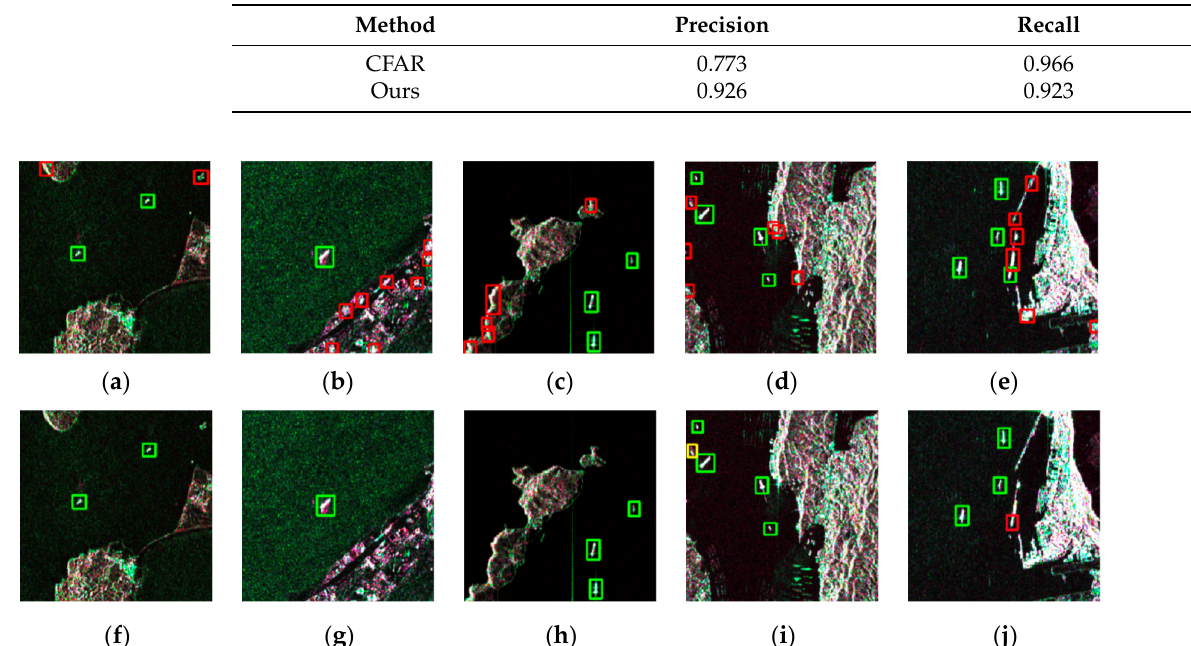
Figure 20. Illustration of detection results where red boxes represent false alarms, yellow boxes are missed ships, and green boxes are correct ships. ( a – e ) are detection results of two-parameter CFAR; ( f – j ) are detection results of our method that adds the MemAE module. Our method significantly screened false alarms by using an anomaly detection approach with acceptable recall loss.